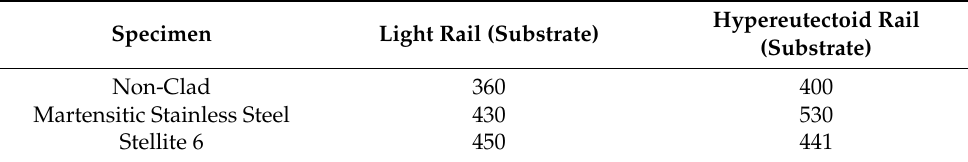
Table 3. Average hardness (HV5) of cladding alloys and substrates.